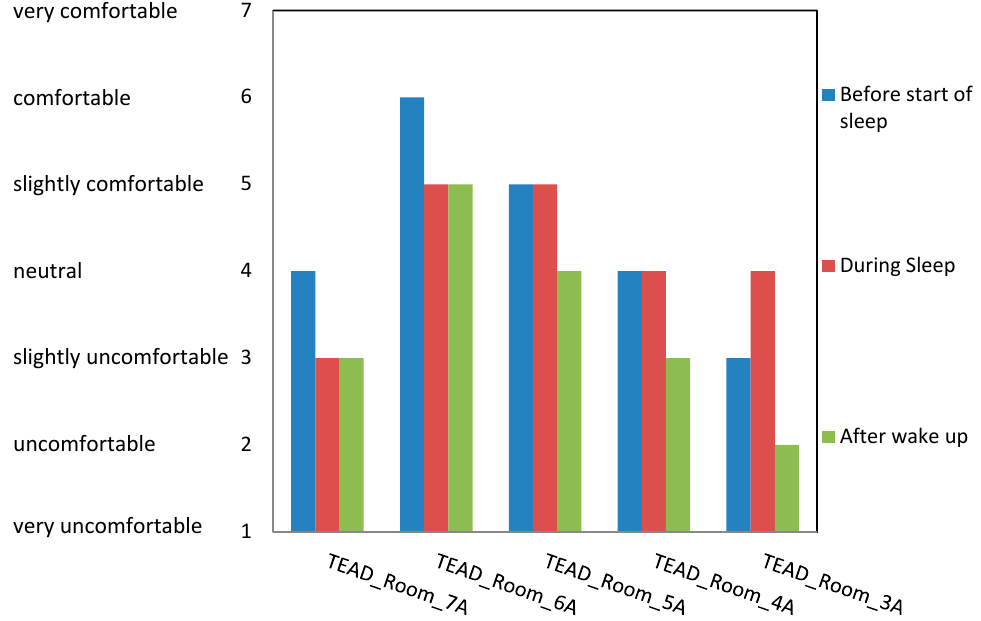
Figure 15. Variation in comfort sensation at different operating powers to the thermoelectric air duct (TE-AD) system.